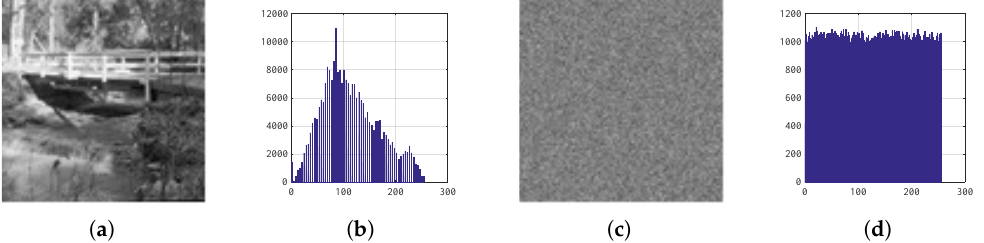
Figure 9. Histograms: ( a ) Bridge image, ( b ) histogram of plain Bridge, ( c ) encrypted Bridge, and ( d ) histogram of encrypted Bridge.